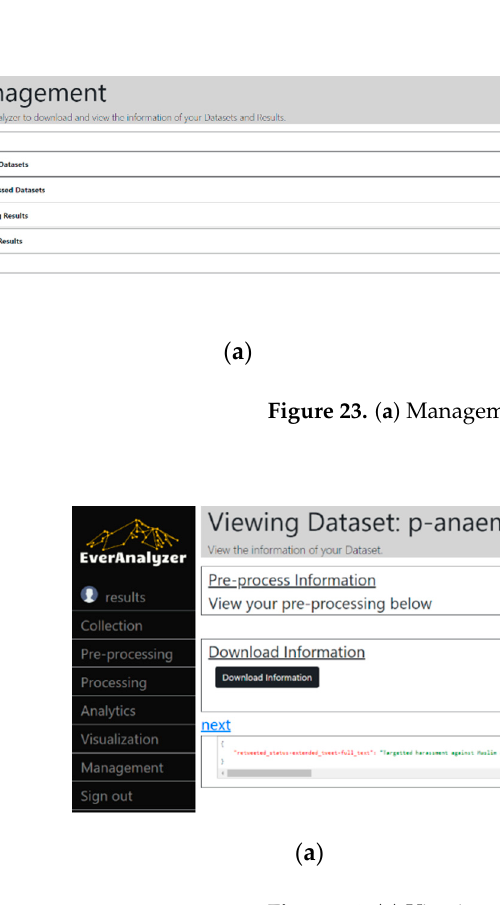
Table 4. Pre-processing results.